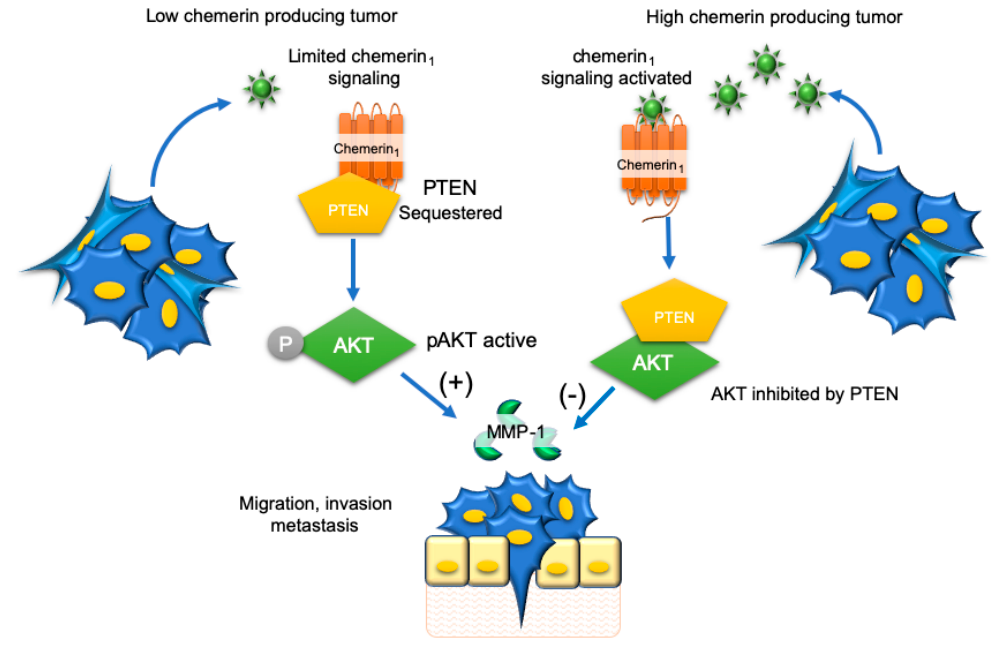
Figure 5. Hepatocellular carcinoma-derived chemerin inhibits tumor cell migration, invasion, and metastasis via an autocrine mechanism. When chemerin production by hepatocellular carcinoma is low (left) there is limited autocrine signaling through chemerin 1 . This results in sequestering of the tumor suppressor phosphatase and tensin homolog (PTEN) through a direct physical interaction with chemerin 1 , allowing for the activation of protein kinase B (AKT) and secretion of matrix metalloproteinase 1 (MMP-1), which is thought to facilitate migration, invasion, and metastasis. When chemerin production by hepatocellular carcinoma is high (right), chemerin 1 signaling is activated, the chemerin 1 -PTEN complex is disrupted, allowing PTEN inhibition of AKT and blockade of migration, invasion, and metastasis of hepatocellular carcinoma. ( + ) = Activation, ( − ) inhibition.